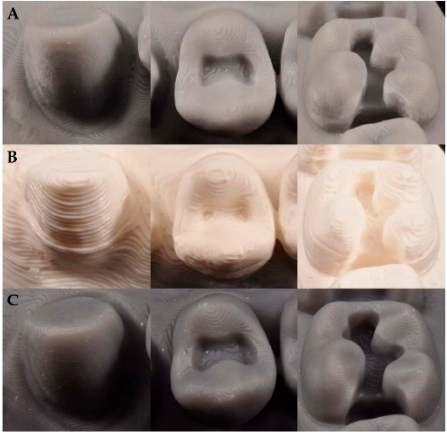
Figure 4. Surface characteristics of three different types of (( A ) digital light processing (DLP), ( B ) fused deposition modeling (FDM), and ( C ) stereolithography apparatus (SLA)) 3D printed models.